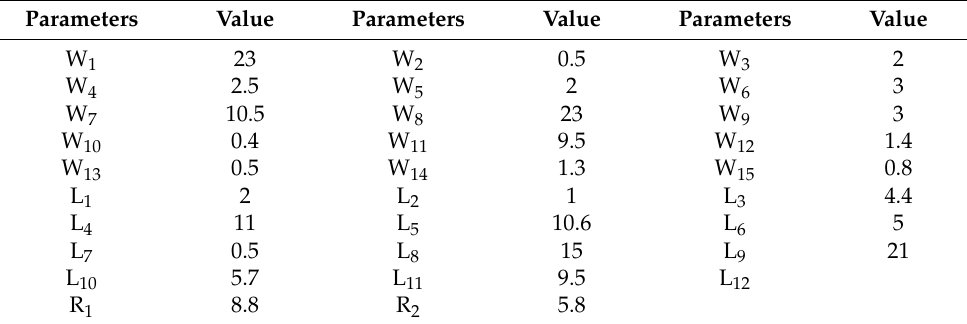
Table 2. Parameters of the proposed antenna (unit: mm).